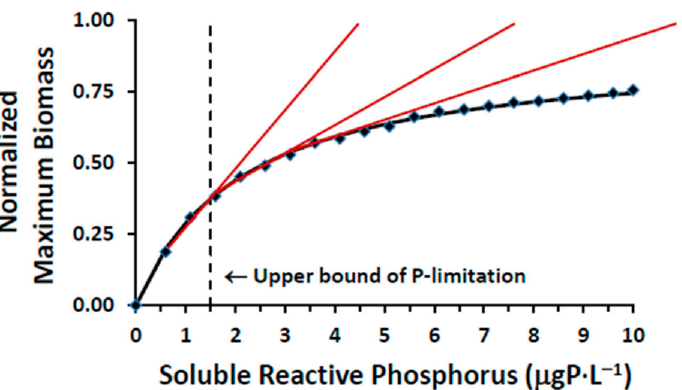
Figure 10. Management metric for the phosphorus– Cladophora dynamic: the relationship between ambient soluble reactive phosphorus concentration and normalized seasonal maximum Cladophora biomass, illustrating the departure from P-limited growth as concentrations exceed an upper bound of 1.5 µ gP · L − 1